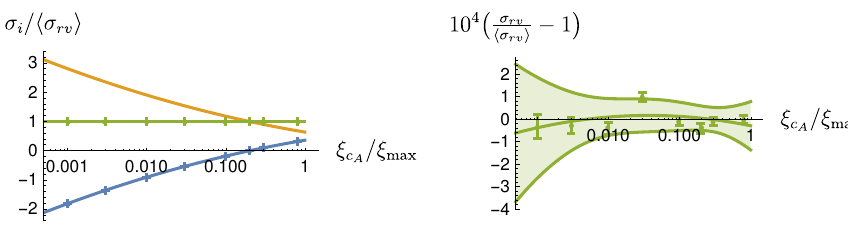
Figure 2 . (cid:24) c (in)dependence of the ( (cid:15) 0 part of the) real-virtual contribution. The combined hard A contributions d (cid:27) (2) (blue, dots and (cid:12)t) and the soft contribution d (cid:27) (2) s (orange) sum up to the total h real-virtual contribution d (cid:27) (2) rv (green), (3.6). The right panel is zoomed into the region of interest, showing 1 (cid:27) con(cid:12)dence bounds to the (cid:12)t. All plots are normalised such that h d (cid:27) (2) rv i = 1.